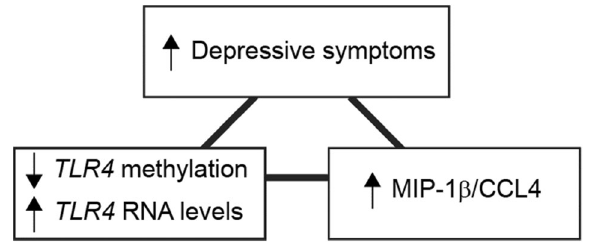
Fig. 1 Overview of the statistical associations. Summary of the statistical associations found between depressive symptoms, methylation grade of TLR4 cg05429895, TLR4 RNA expression levels and MIP-1 β